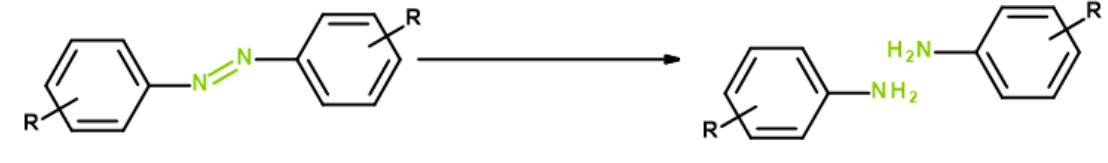
Figure 7. The reductive cleavage of azo-dye linkage.